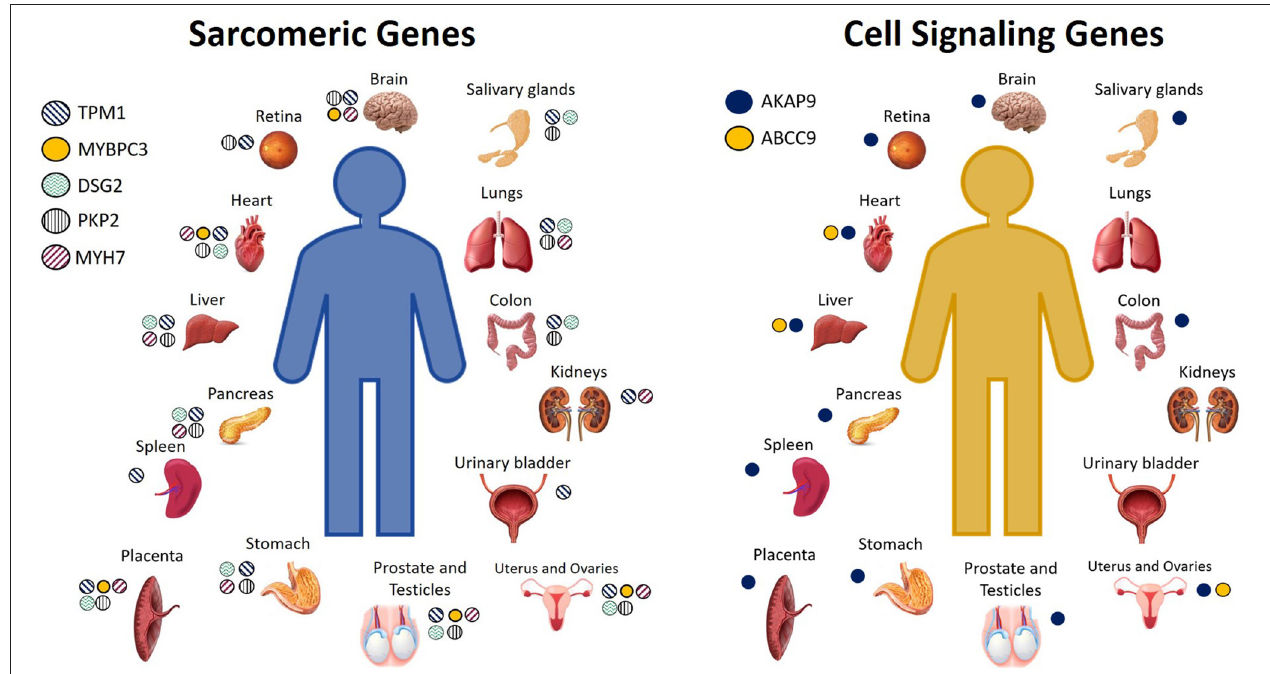
FIGURE 2 | Cell and tissue types in which sarcomeric and cell signaling BrS candidate genes encode for high levels of protein expression. Not pictured: Sarcomeric genes: TPM1 : Serum, plasma, monocytes, neutrophil, B lymphocytes, CD8T cells, NK cells, PBMCs, platelets, lymph nodes, tonsils, bone marrow, fetal brain, spinal cord, fetal heart, bone, oral epithelial, nasopharynx, esophagus, cardia, gut fetal, rectum, fetal liver, adipocytes, amniocytes, thyroid, adrenal, breast, milk, gallbladder, urine, skin, fetal ovary, fetal testis, seminal vesicles. MYBPC3 : fetal brain, fetal heart, oral epithelium, fetal liver, adrenal, fetal testis. DSG2 : serum, plasma, platelets, tonsils, fetal heart, oral epithelia, esophagus, cardia, fetal gut, rectum, fetal liver, adipocytes, synovial fluid, amniocytes, thyroid, breast, gallbladder, urine, urinary bladder, skin, fetal ovary. PKP2 : platelets, spinal cord, fetal heart, fetal gut, rectum, amniocytes, adrenal, breast, gallbladder, skin, fetal ovary, fetal testis. MYH7 : platelets, tonsil, fetal brain, spinal cord, fetal heart, esophagus, rectum, fetal liver, adipocytes, fetal ovaries, fetal testis. Cell signaling genes: AKAP9 : monocytes, PBMCs, platlets, lymph node, brain fetal, esophagus, cardia, rectum, fetal liver, adipocytes, amniocytes, adrenal, pancreatic juice, islet of Langherans, gallbladder, ovary fetal, testis fetal. ABCC9 : plasma, bone marrow, heart fetal, fetal liver (29).